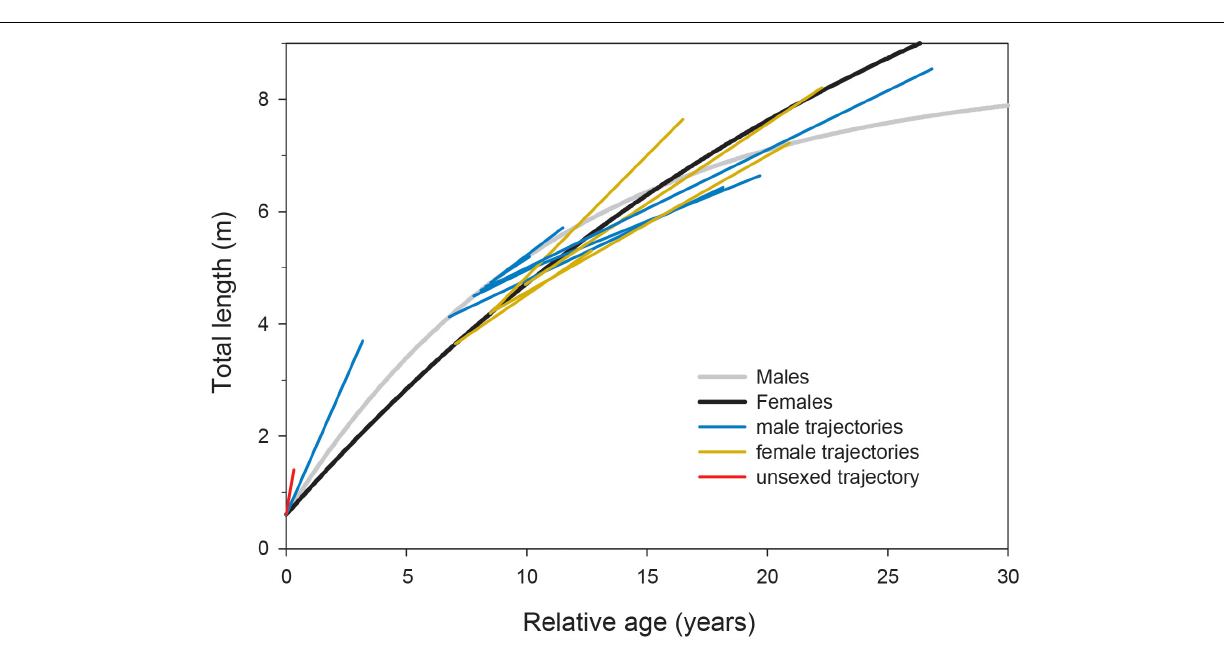
FIGURE 4 | Growth trajectories for whale sharks kept in captivity overlaid onto growth profiles modeled from Ningaloo Reef, Western Australia, with the initial age predicted by sex-specific growth curve parameters. Four observations (two males, two females; unpublished data) are from the Georgia Aquarium (United States), each spanning over a decade; two observations (one male, one female; Wintner, 2000) are from the Osaka Aquarium Kaiyukan (Japan) spanning 3–8 years; five observations (four males, one female; Uchida et al., 2000; Nishida, 2001; Matsumoto et al., 2019) are from the Okinawa Churaumi Aquarium (Japan) spanning approximately 1–18 years; and one observation (unsexed; Chang et al., 1997) is from the National Museum of Marine Biology and Aquarium (Taiwan) spanning 120